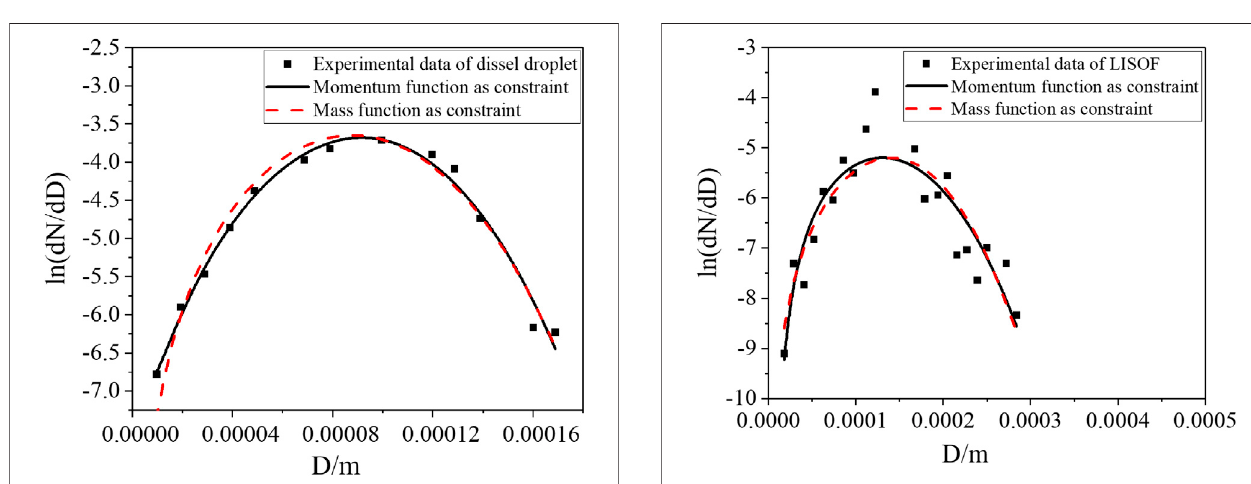
FIGURE 6 | Results of LISOF sodium droplet size distribution under the pressure difference of 0.6 MPa.